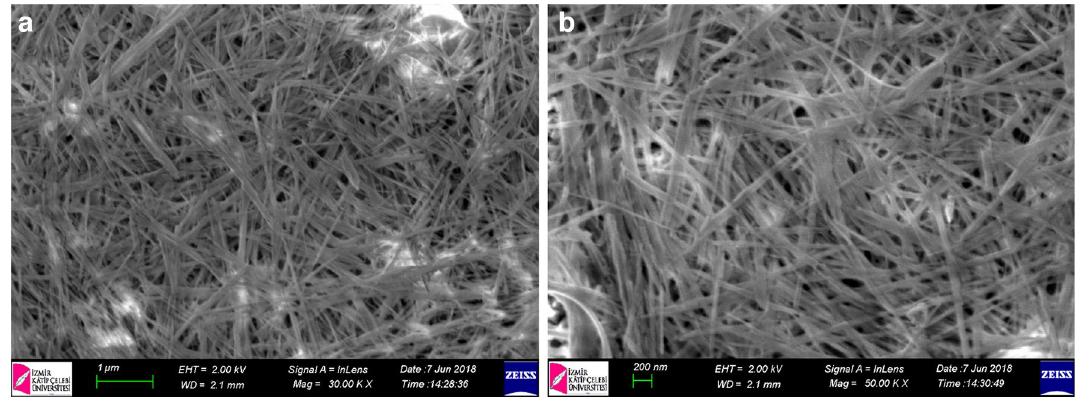
Figure 1. SEM image of aerosol coated sepiolite films on FTO glasses obtained from 1 mg/ml dispersion in water. ( a ) 30KX and ( b ) 50KX